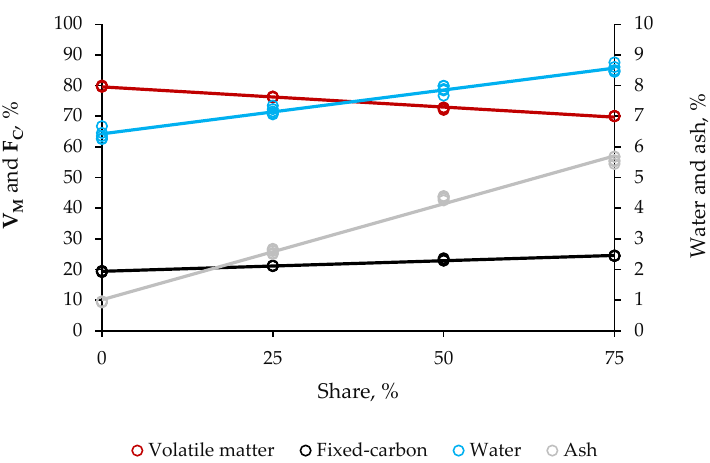
Figure 4. Effect of share of residual biomass from distillation of cellulosic bioethanol in the blend with sugarcane bagasse on the proximal properties of hybrid non-wood pellets. The steeper the line is, the larger the probability of the factor becoming the cause of significant variability is, as it gains in linearity; volatile matter (V M ) and fixed carbon (F C ).